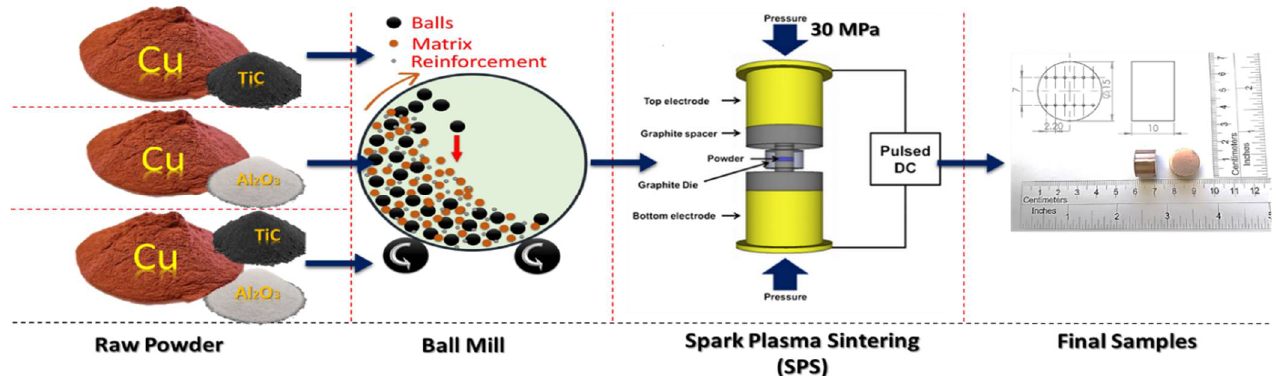
Figure 1. Schematic diagram of Cu with TiC and Al 2 O 3 and (TiC + Al 2 O 3 ) hybrid nano reinforcement composites. Table 1. Composition of the prepared specimens and their contents in the Cu matrix. Composition Materials after Sintering by (SPS)